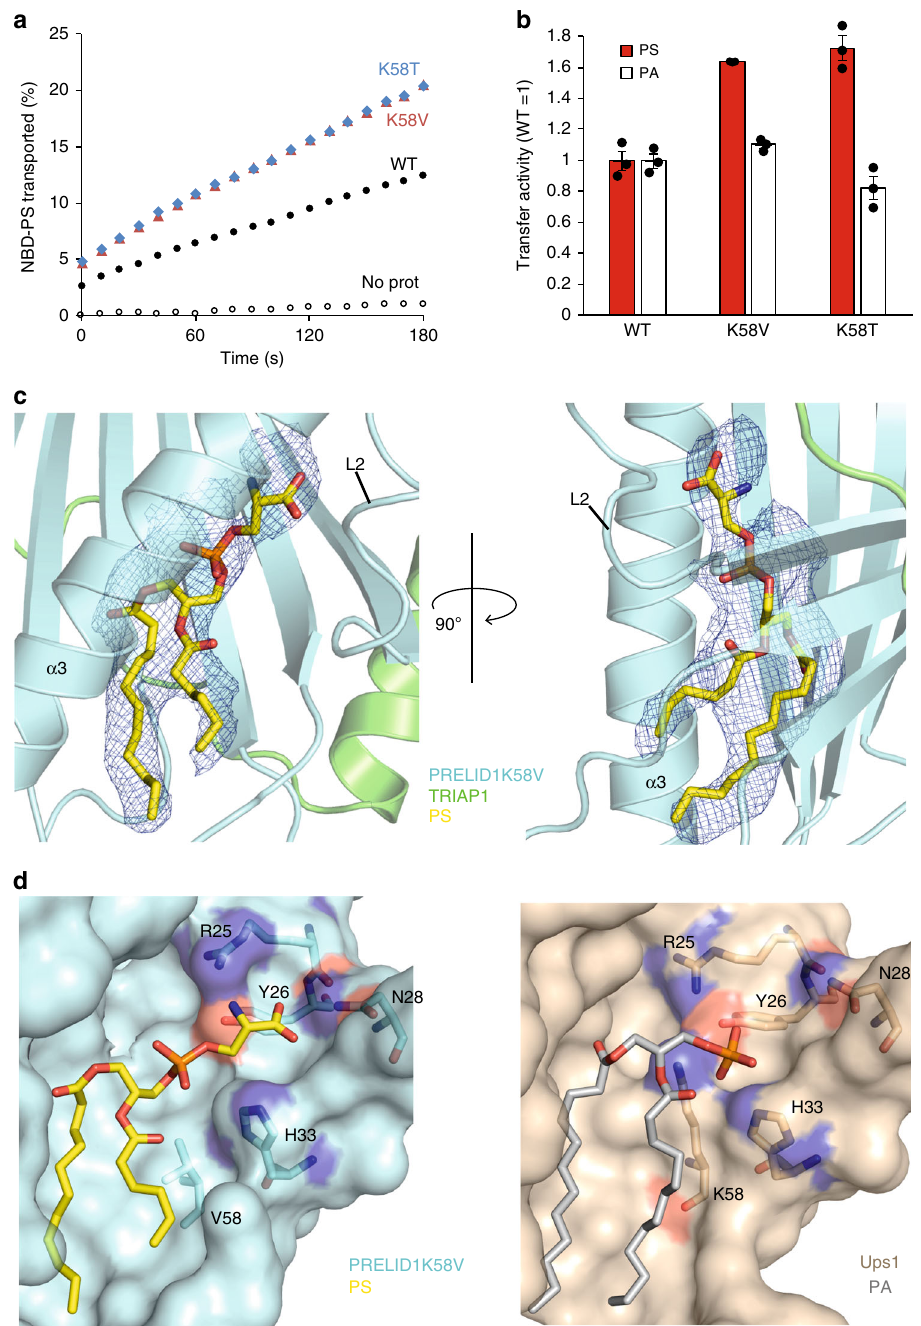
Fig. 4 Characterisation of PS-bound PRELID3b mutants. a PS transfer by PRELID1, PRELID1 – K58V (red triangles) or PRELID1-K58T (cyan diamonds). Assays are performed as in Fig. 3a, except that 120 nM protein was used. b PA and PS transfer activity of wildtype PRELID1 and mutant variants. Error bars represent mean ± SEM, n = 3. See also Supplementary Figure 4. c Left; PS headgroup orientation 1, with serine group protruding towards β -sheet of PRELID1 – K58V (cyan). Right; PS headgroup orientation 2, with serine group protruding towards loop 2 of PRELID1. Electron density map for PS. The F o − F c difference Fourier map was calculated by omitting PS, and is shown in cyan sticks surrounded by blue meshes countered at 3.0 σ . d Comparison of PA- binding site in Ups1 and the PS-binding site of PRELID1 – K58V-PS. Zoom in view of superposition of PRELID1 – K58V-PS (cyan) and Ups1-PA (beige). All residues are numbered according to the protein